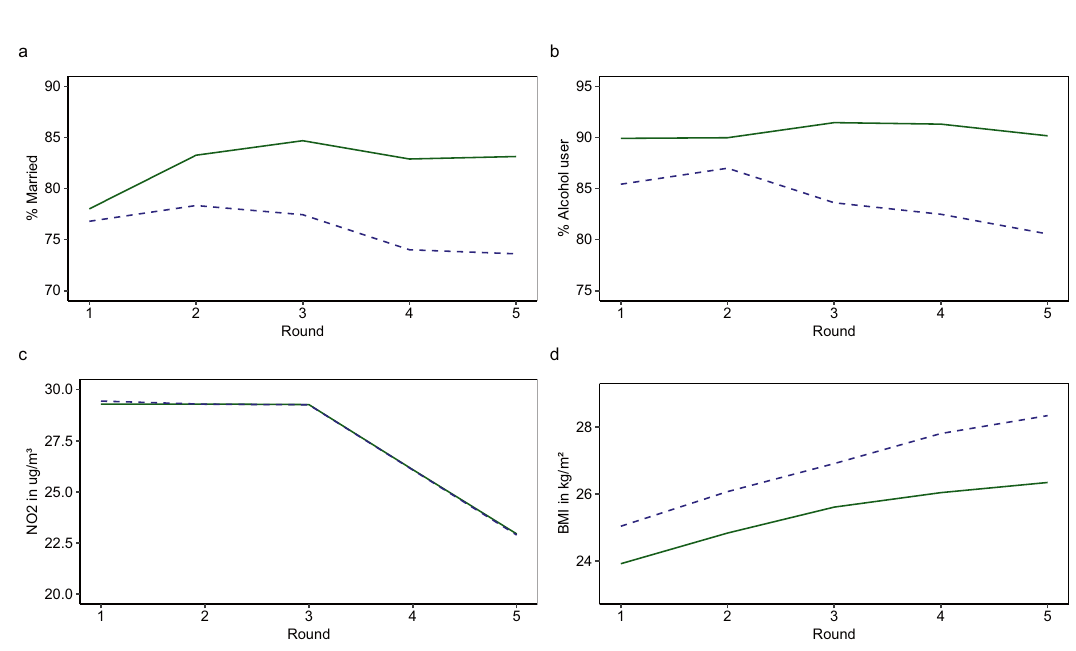
Figure 3. Examples of average trajectories over time of a demographic ( a ), a lifestyle ( b ), an environmental ( c ), and a biological ( d ) exposure for those with good (solid green line) and poor (dashed blue line) perceived health status at round